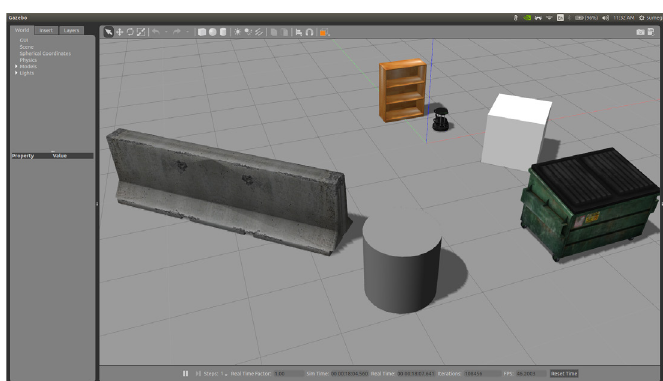
Fig. 2: Simulated environment in